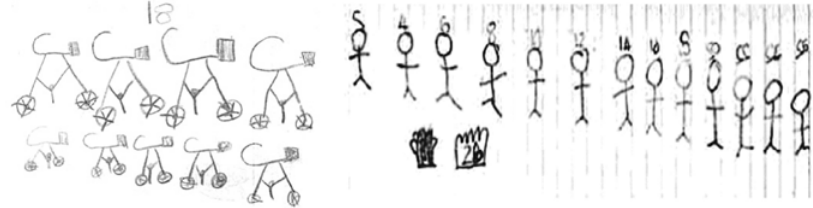
Figure 2: Learner solution A Figure 3: Learner solution